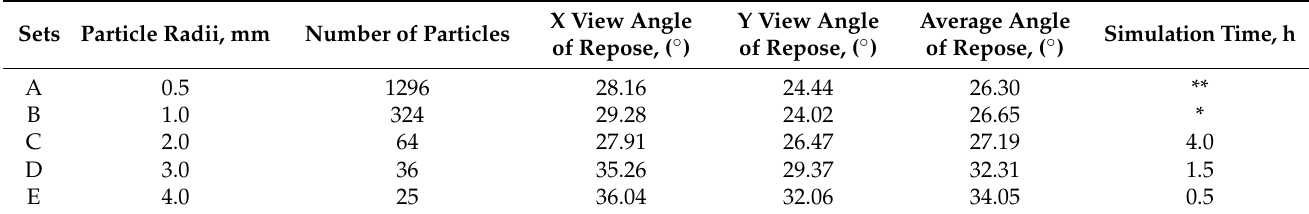
Table 4. The simulation angle of repose and simulation time of sugarcane leaf model.